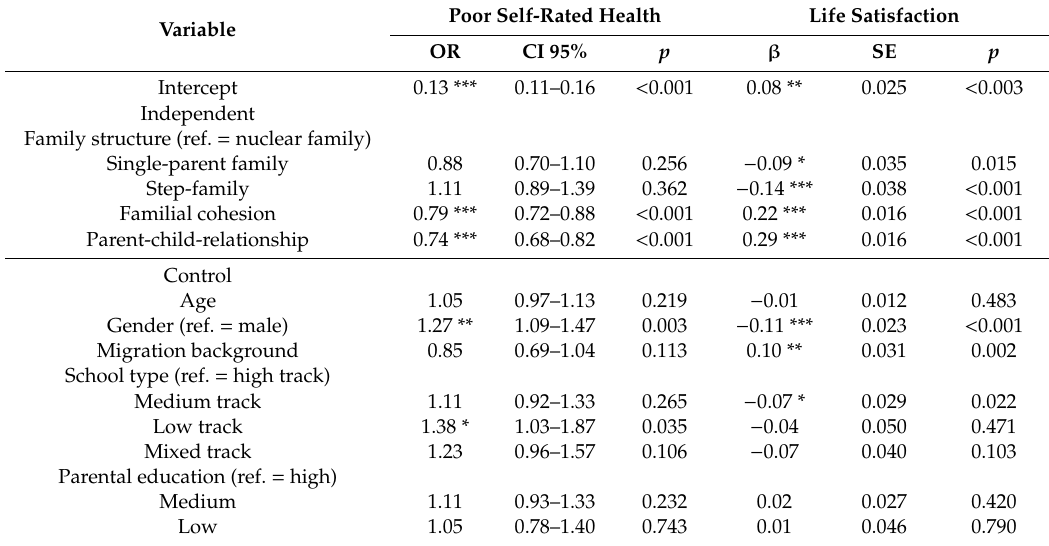
Table 2. Results for poor self-rated health (logistic regression) and life satisfaction (linear